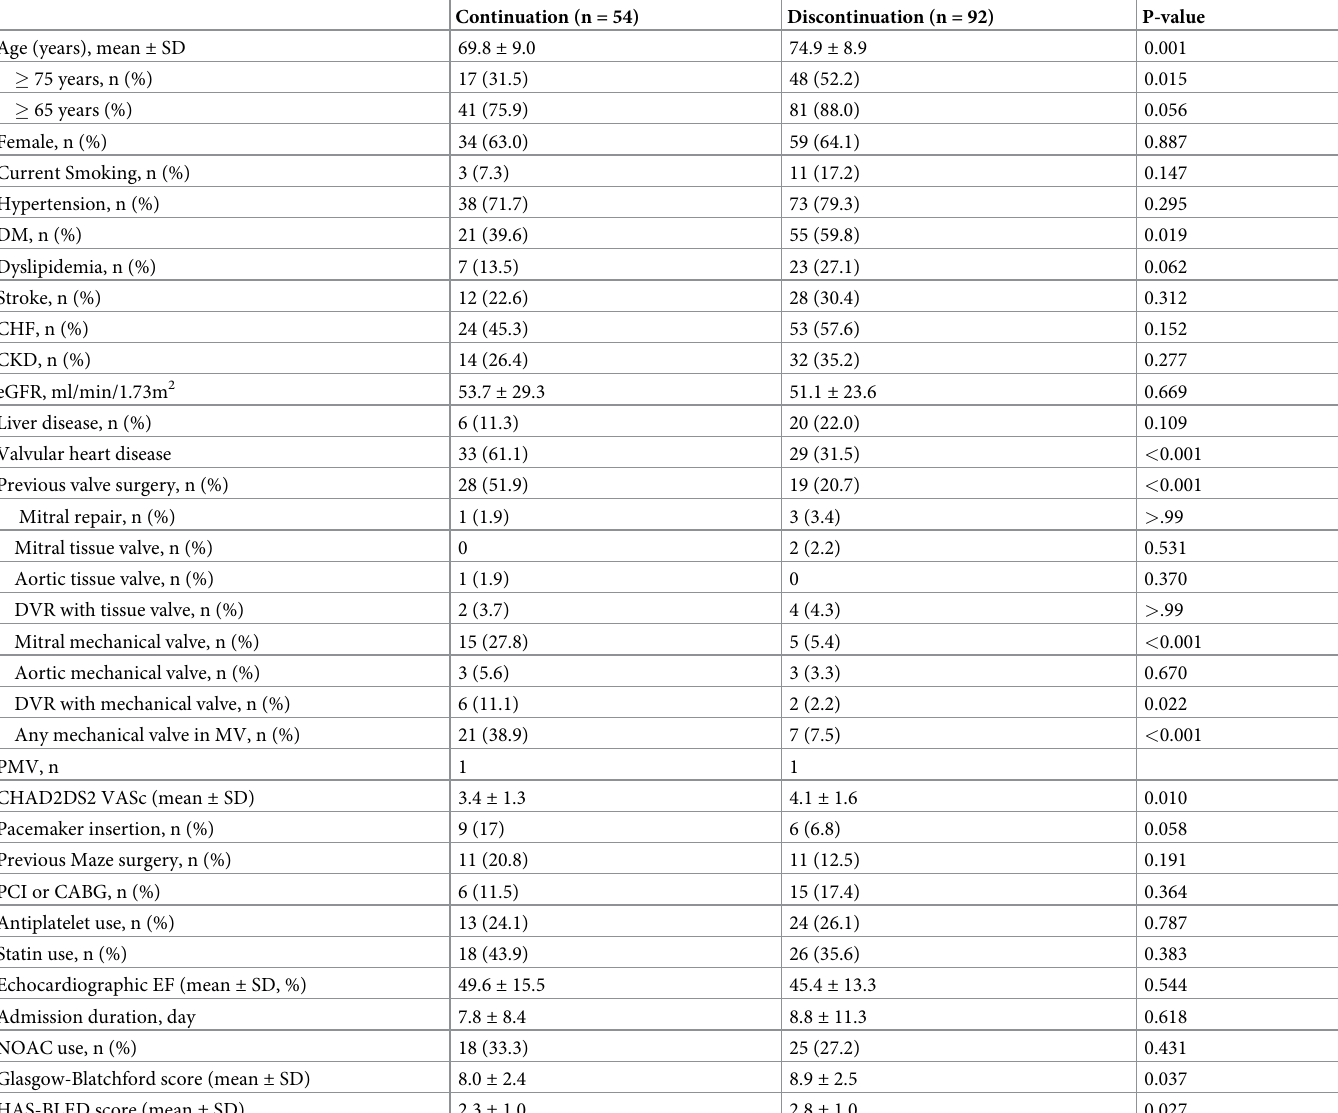
Table 1. Clinical characteristics of patients with gastrointestinal bleeding according to the strategies for oral anticoagulation